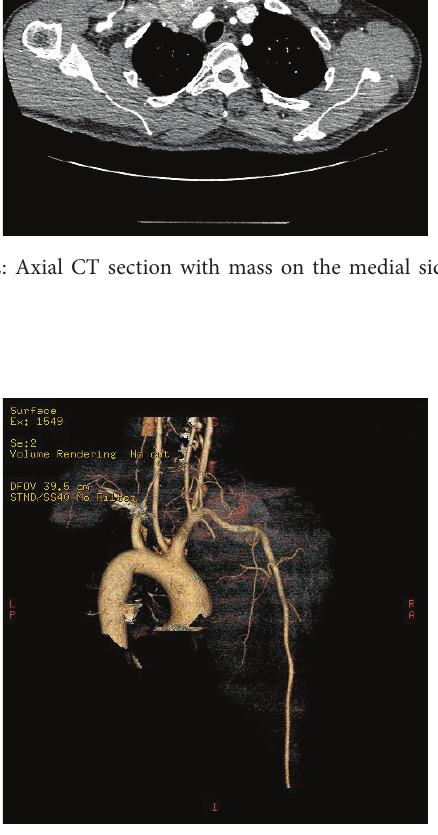
F 3: Preoperative CT-guided angiography displaying no vas- cular involvement but close proximity.